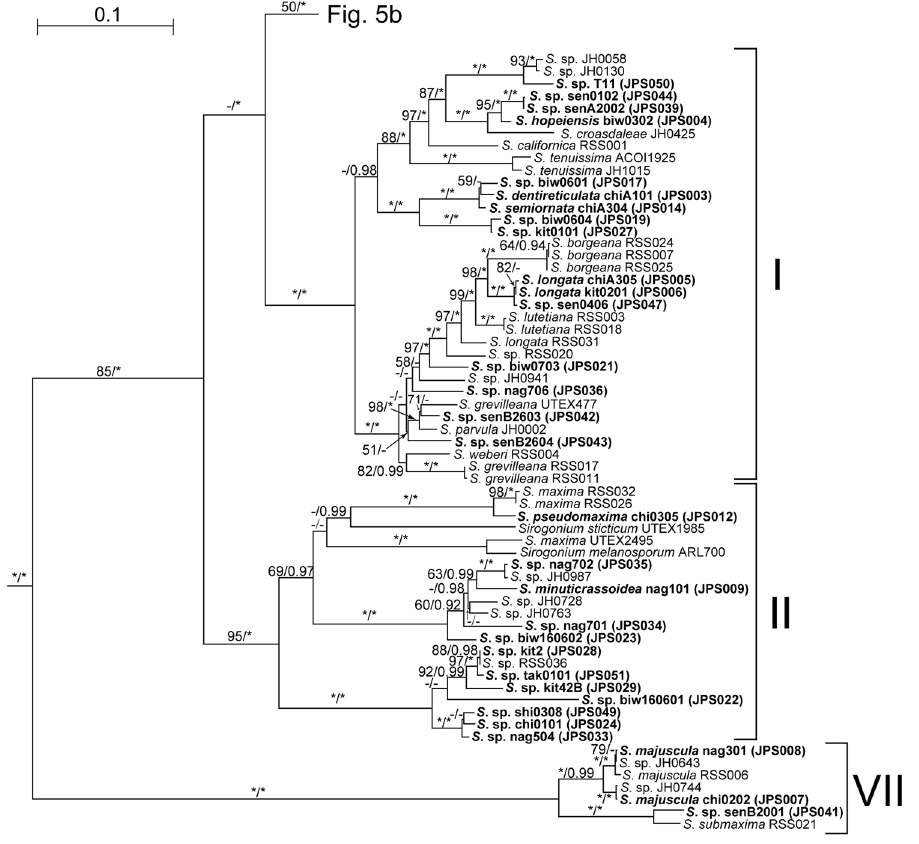
Figure 6. Details of part of the ML tree based on the combined data set from rbcL and atpB genes (Fig. 5a) showing a section corresponding to Clades I, II and VII of Stancheva et al . 11 . For details of the explanation of the tree, see Fig.